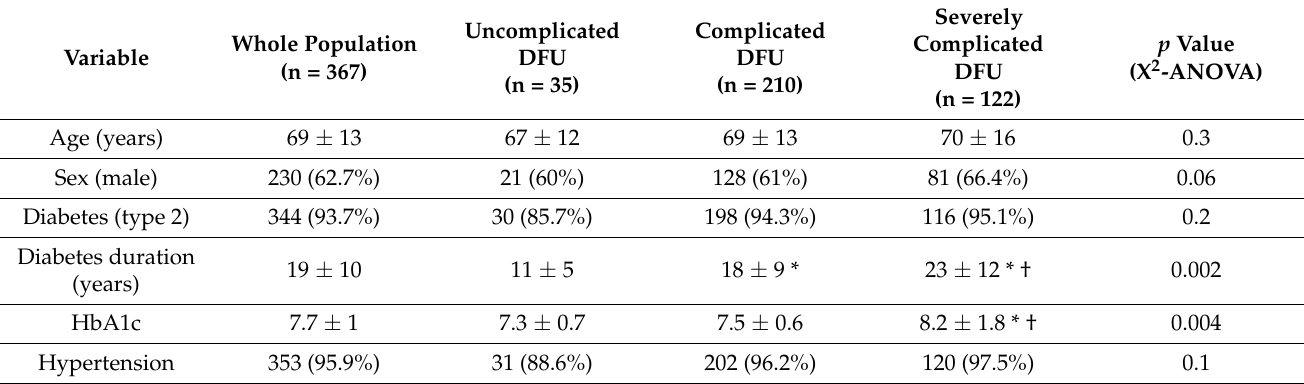
Table 2. Baseline demographic, clinical, and wound characteristics of the whole population and the sub-groups defined by DFU severity. Data are n (%) or means ± SEM or %. * p < 0.05